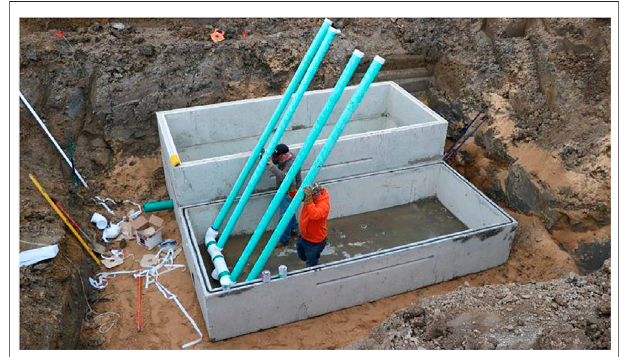
(not yetinstalled)and leaves outapipenear thetop(not pictured)thatleadsto a nearby surface drain (not pictured). Photo credit: Macatawa Area Coordinating Council.